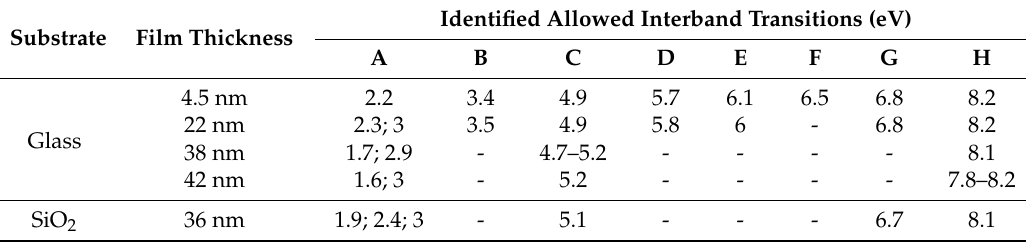
Table 1. Allowed interband transitions identified in the spectral behavior of reflectance.